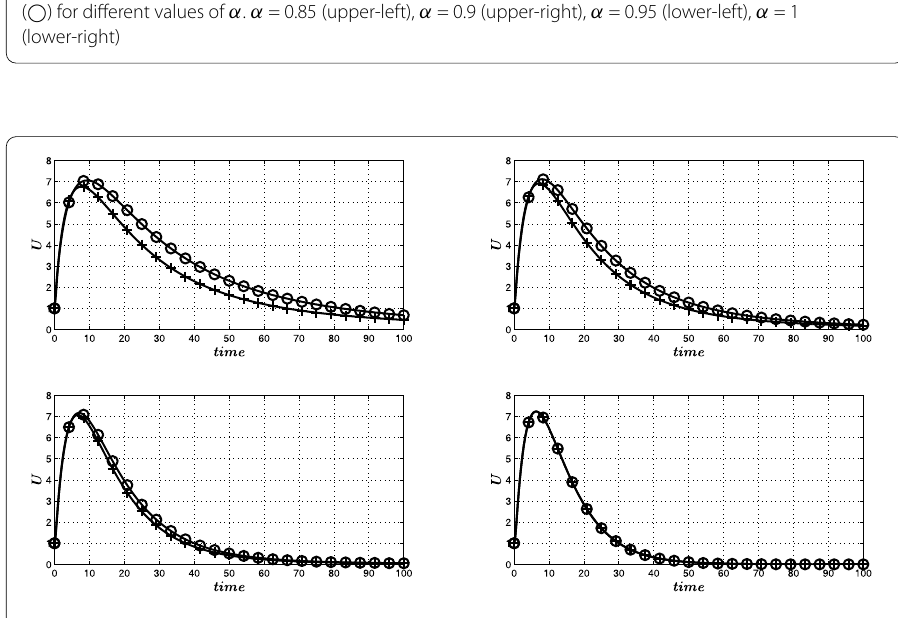
Figure 6 Asymptotic behaviour of U within the classic Caputo derivative (+) and ABC fractional operator ( (cid:11) ) for different values of α . α = 0.85 (upper-left), α = 0.9 (upper-right), α = 0.95 (lower-left), α = 1